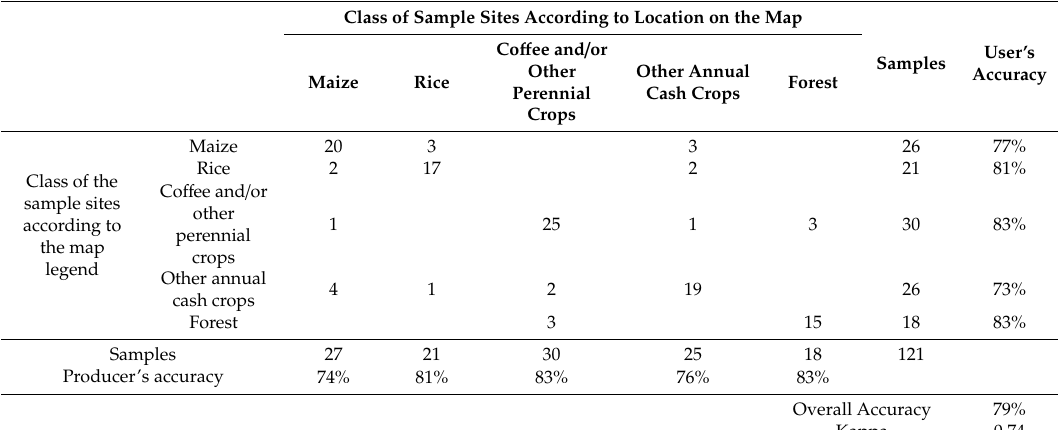
Table 1. Accuracy of the 2018-produced map of the maize cropping patterns and other vegetation covers. Class of Sample Sites According to Location on the Map